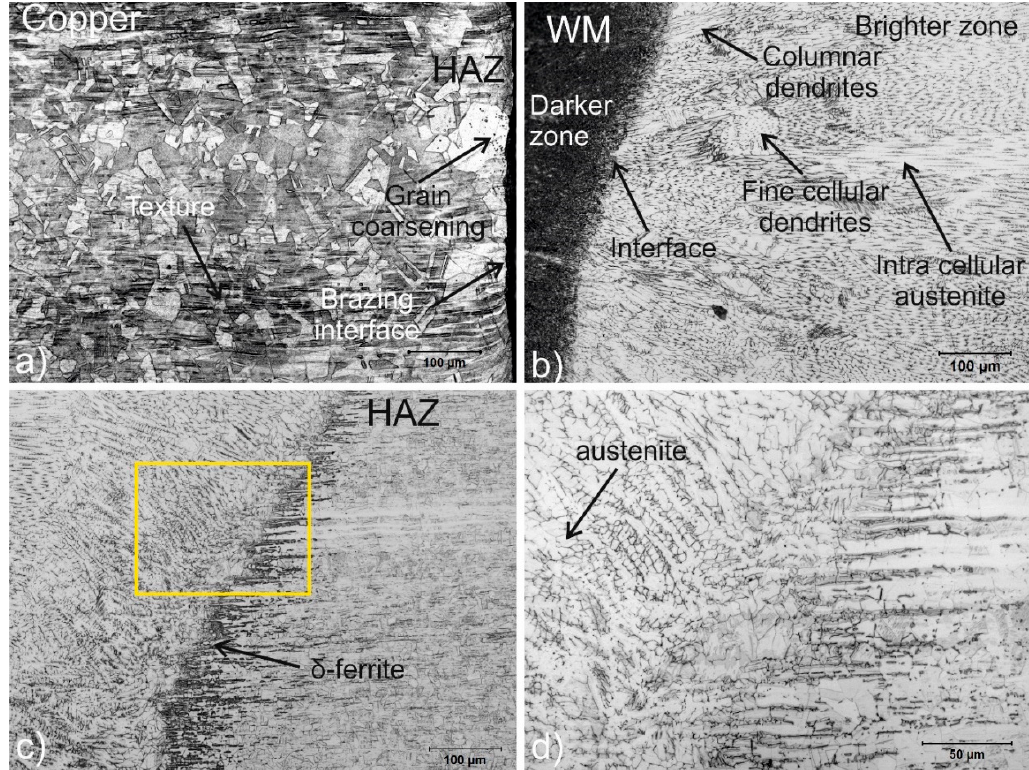
Figure 5. ( a ) Copper base metal-HAZ-fusion zone transition of weld No. 1; ( b ) copper weld metal-AISI 304 weld metal interface; ( c ) weld metal-AISI 304 HAZ interface; ( d ) higher magnification of the zone marked in ( c ).